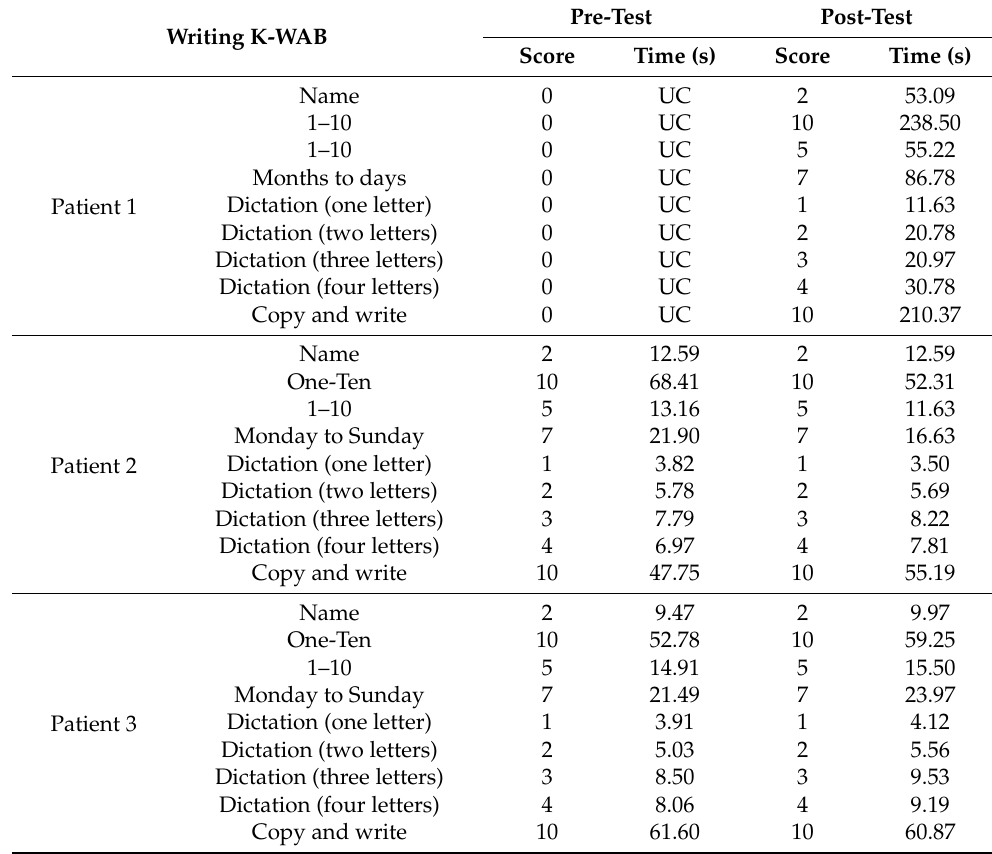
Table 3. Results based on the writing K-WAB